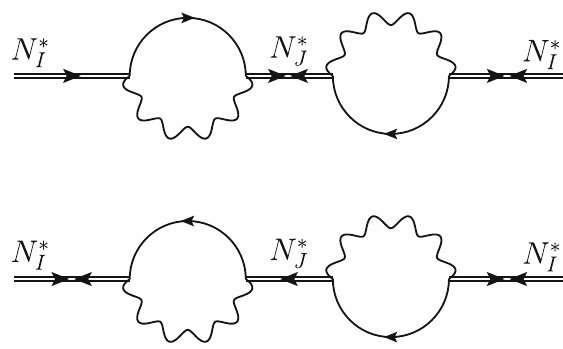
Fig. 4 Self-energy diagrams for the I th composite Majorana neutrino. The imaginary parts, namely the cutting through lepton and gauge boson lines, corresponds to the interference of tree-level and one-loop vertex diagram in Fig. 3. We show the two possible diagrams due to Majorana field contractions